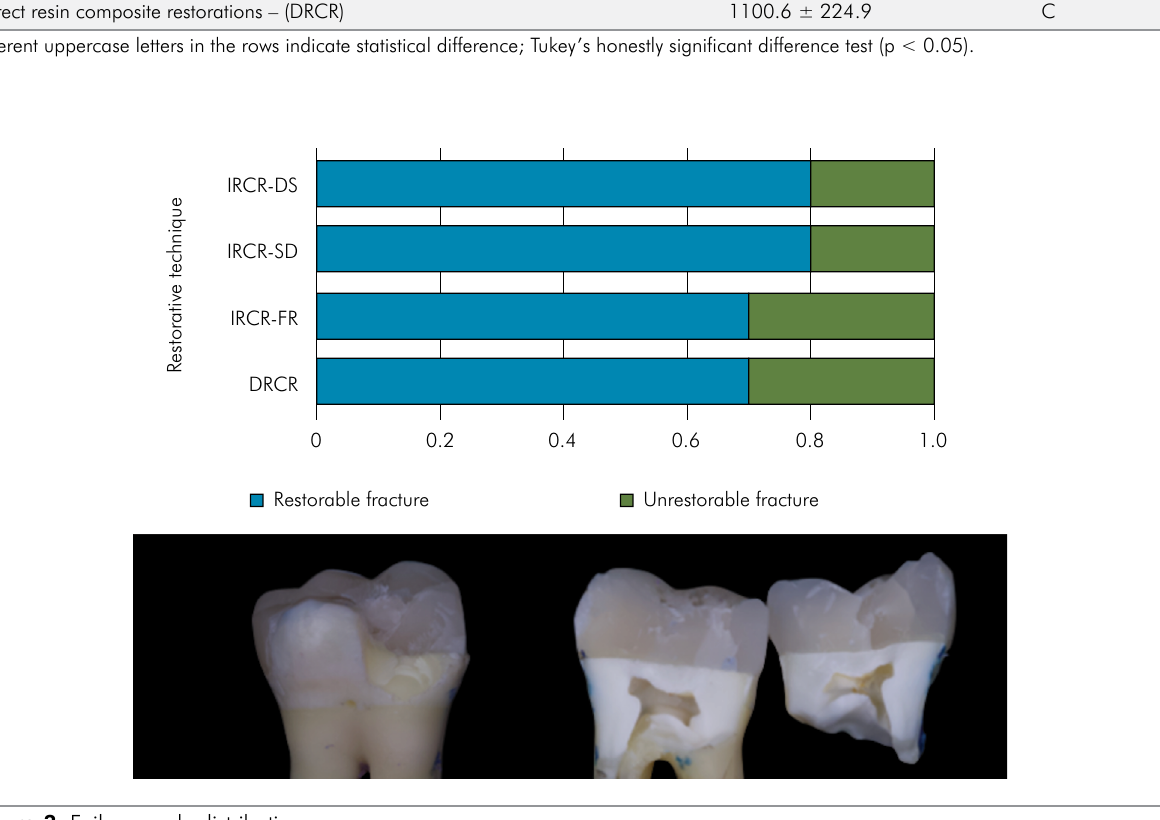
Figure 3. Failure mode